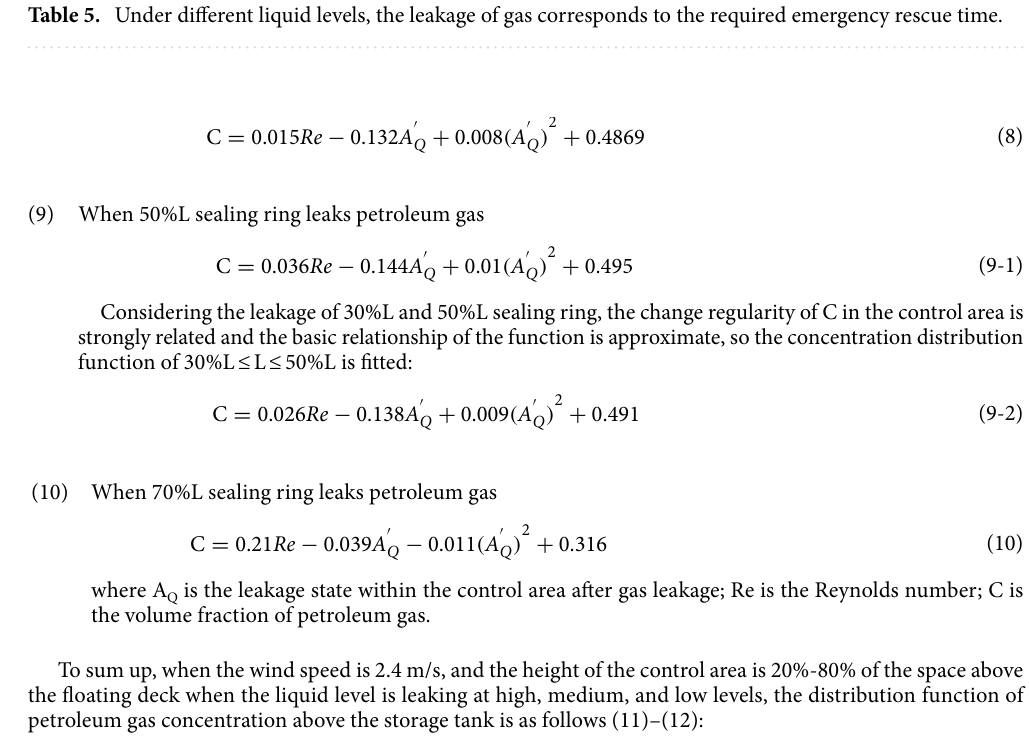
Table 5. Under different liquid levels, the leakage of gas corresponds to the required emergency rescue